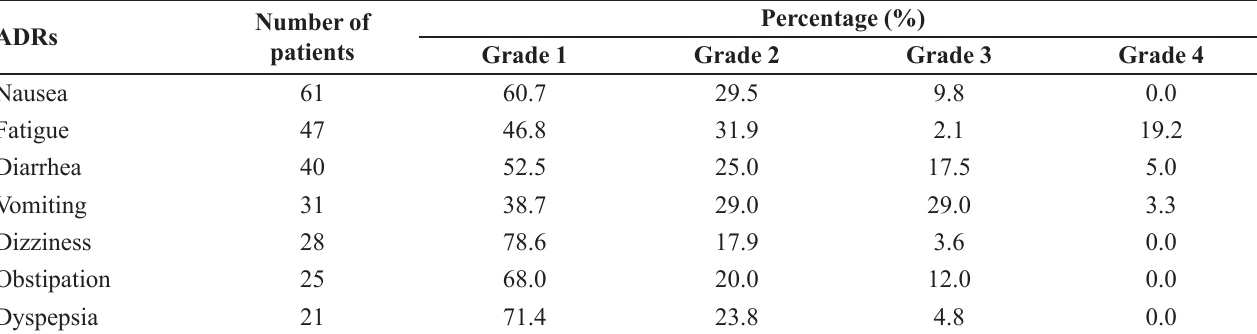
TABLE V - Distribution of patients according to the degree of toxicity of the adverse drug reactions (ADRs) presented by outpatients of the Chemotherapy Clinic from October to November 2010 (National Cancer Institute Common Terminology Criteria for Adverse Events, CTCAE, version